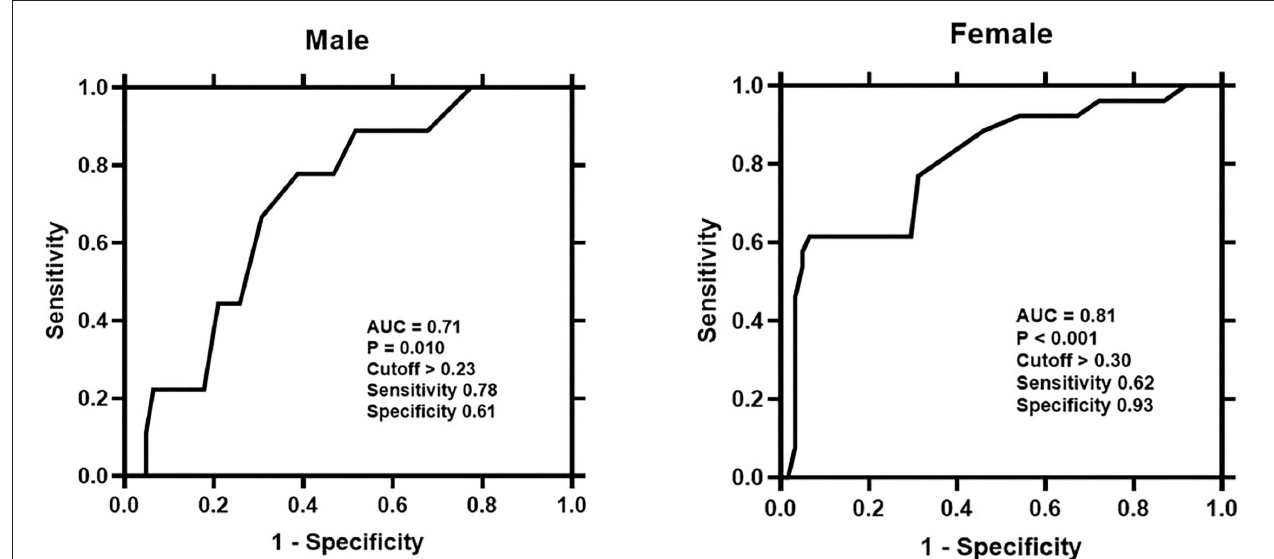
FIGURE 4 | Receiver-operating-characteristic (ROC) curve analysis evaluating the predictive performance of P/T EAT ratio for atrial fibrillation recurrence in the male and female. The cutoff value of P/T EAT ratio for predicting AF recurrence and its sensitivity and specificity were presented. P/T EAT ratio, proportion of periatrial to total EAT.